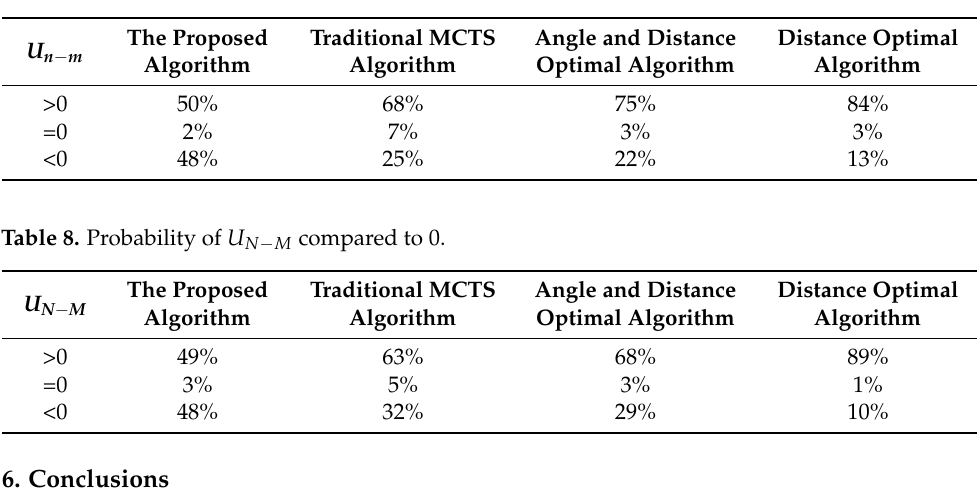
Table 7. Probability of U n